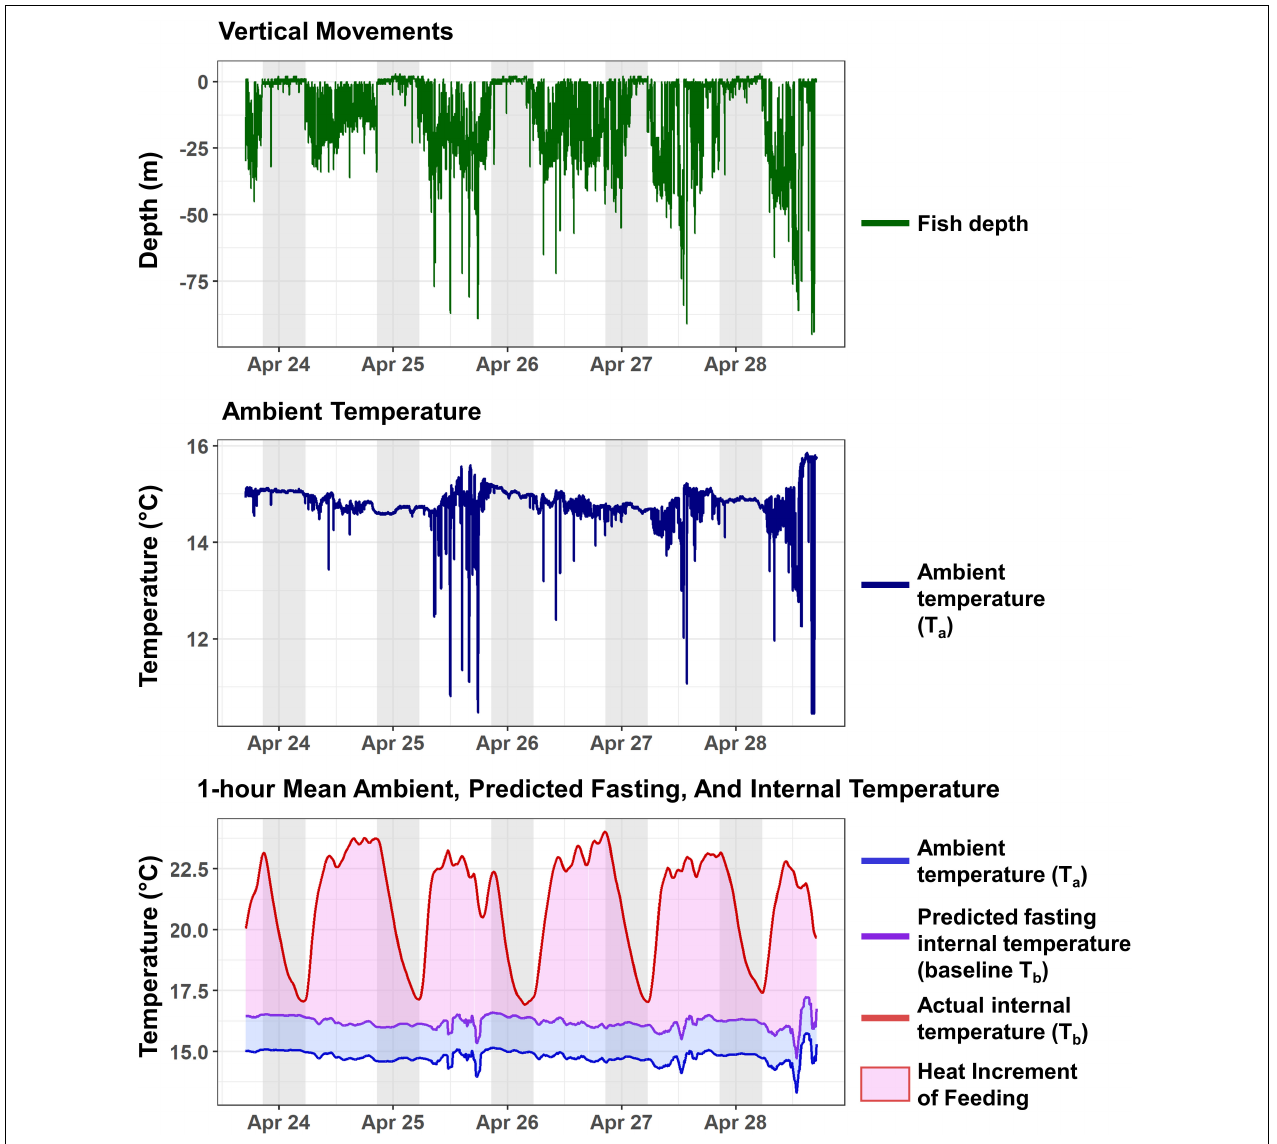
FIGURE 2 | Five days of HIF events for tag 1973 in the CCALS, April 24–28, 2004. Top: depth occupied at 1-min intervals. Middle: ambient water temperature recorded by the tag at 1-min intervals. Bottom: 1-h moving mean of ambient temperature, estimated baseline (fasting) internal temperature, and measured internal temperature. The light pink area denotes the internal temperature increase due to HIF, while the purple area is the estimated thermal excess maintained by the fish under fasting conditions. Gray shading denotes nighttime, defined as time between nautical dusk and nautical